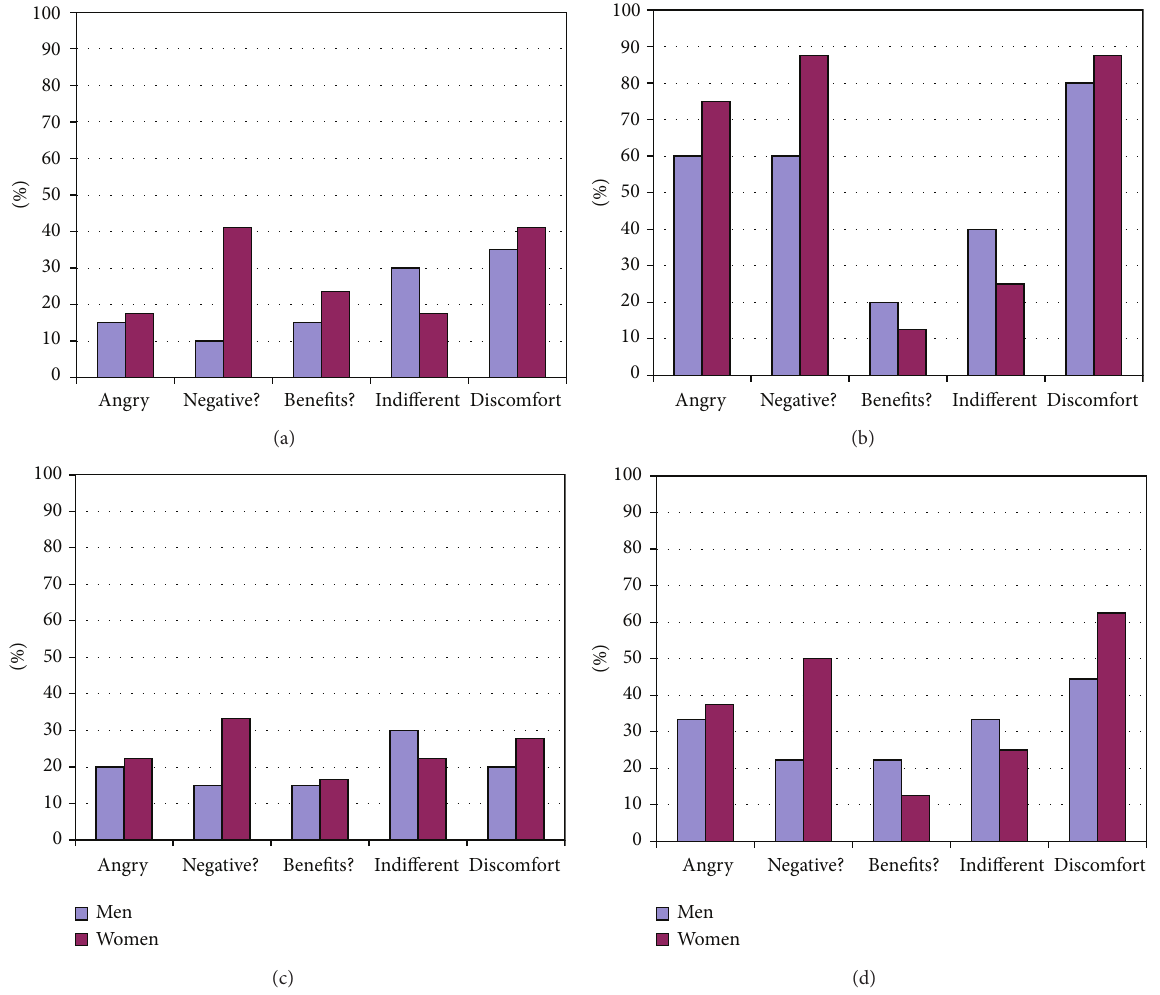
Figure 15: Users reaction if third parties would access their personal location: (a) DNs who claim to use location-aware applications; (b) DNs who claim not to use location-aware applications; (c) DIs who claim to use location-aware applications; (d) DIs who claim not to use location-aware